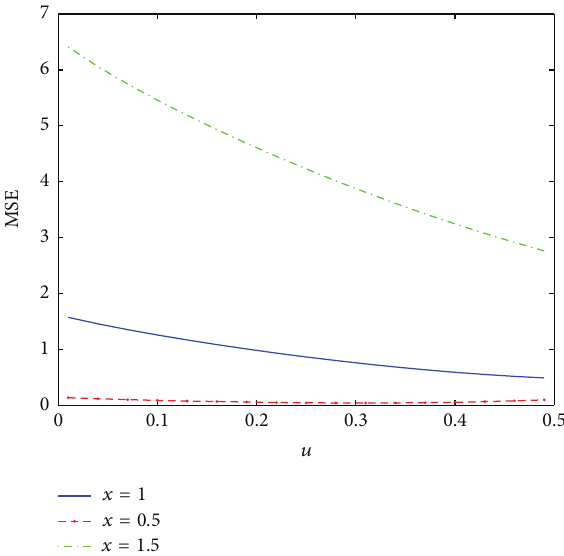
Figure 2: MSE of (10) at 𝑥 = 0.5 , 𝑥 = 1 , and 𝑥 = 1.5